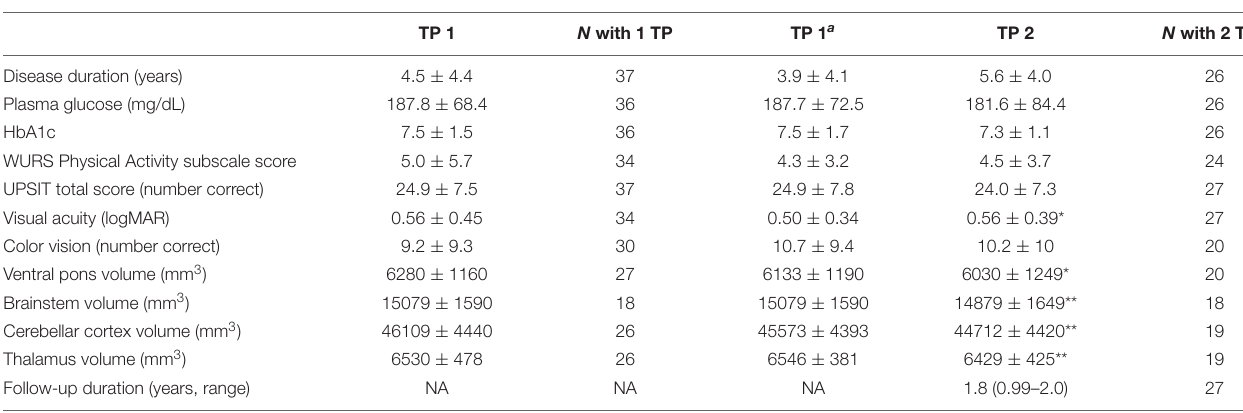
TABLE 2 | Clinical severity measures in individuals with Wolfram